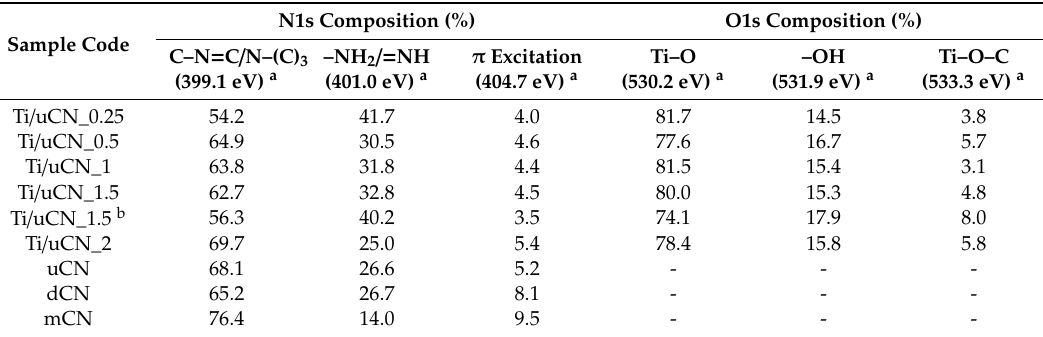
Table 3. Surface composition of nitrogen-contained and oxygen-contained functional groups based on XPS N1s or O1s fitting